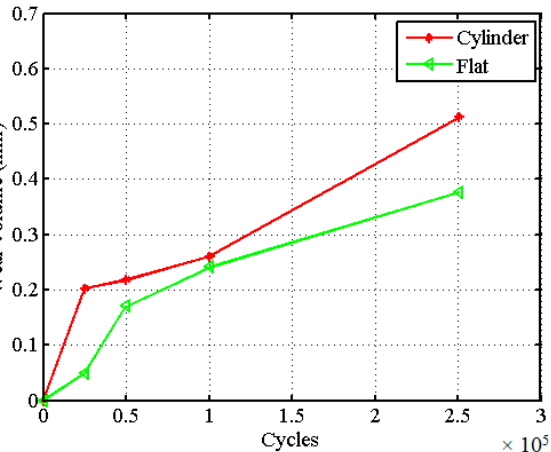
Figure 9. Wear coefficient changes with the number of cycles for both flat specimen and cylindrical pad. To obtain the wear coefficient for every cycle period of the flat and cylindrical pad, relative slip amplitude on the contact surface, δ should be known at first. Based on Equation (1), the estimated wear coefficient is 9.98 × 10 − 9 MPa − 1 in the 25,000 cycles